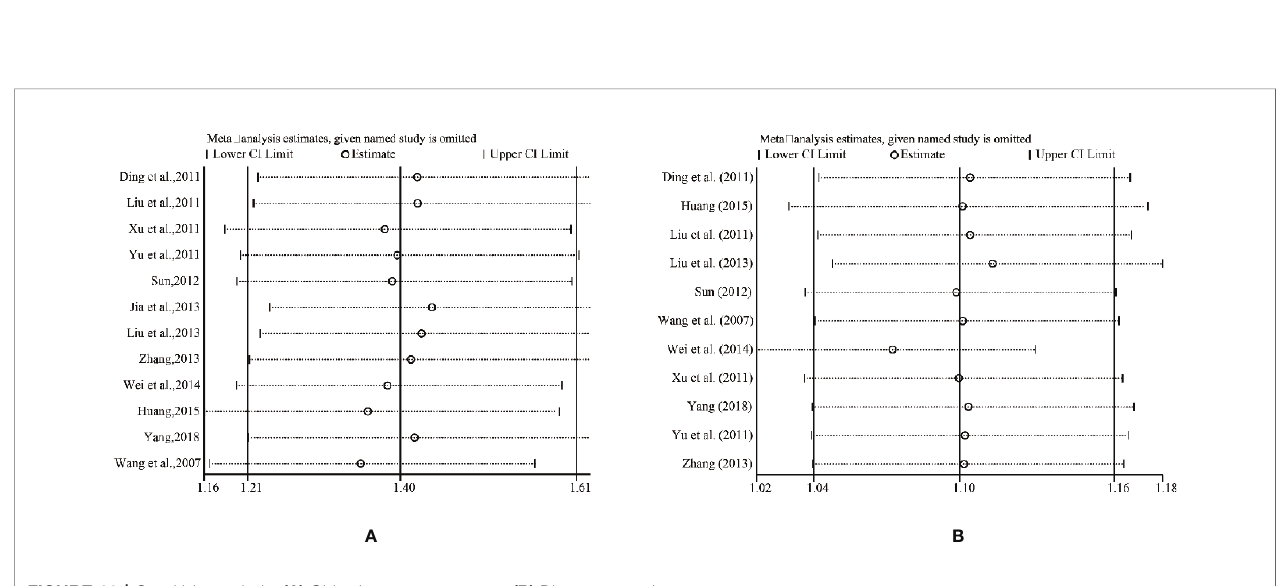
FIGURE 10 | The funnel plots and the Egger ’ s publication bias plots for assessing publication bias. (A) Objective tumor response. (B) Disease control rate. (C) Objective tumor response. (D) Disease control rate.